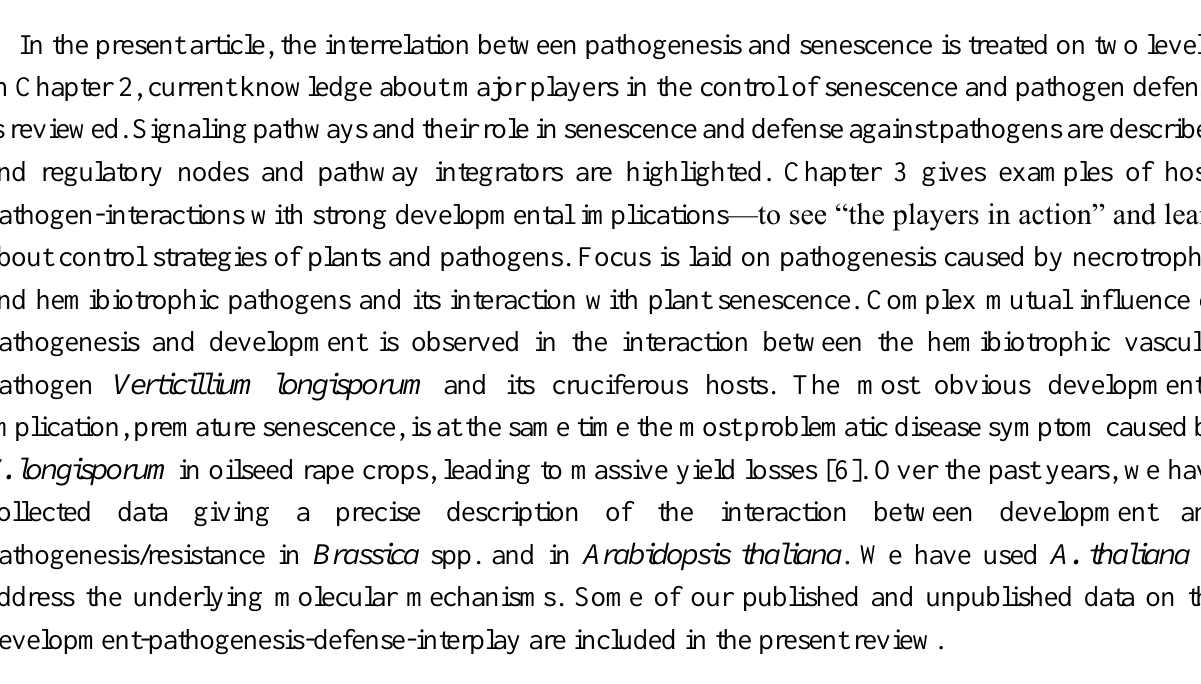
Figure 1. Relationship between senescence and resistance/susceptibility in necrotrophic and biotrophic host-pathogen interactions. Biotrophic pathogens and hemibiotrophs in their biotrophic stage inhibit senescence to increase susceptibility. The host can control pathogen growth and promote resistance by activating senescence-like processes. Necrotrophic pathogens and hemibiotrophs in their necrotrophic stage induce senescence to increase susceptibility. The host can control pathogen growth and promote resistance by inhibiting senescence-like processes. Hemibiotrophs switch from a biotrophic to a necrotrophic lifestyle in the course of their development. Arrows stand for activation/induction, bars for